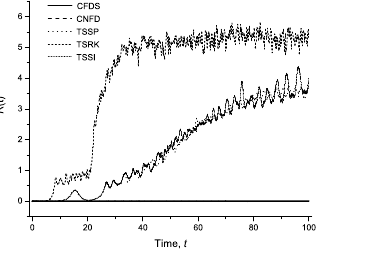
Figure 6. The mean square difference be- tween the absolute values of the soliton solu- tion | u s ( x,t ) | and numerical solutions | u n j | of NLS obtained by different methods.